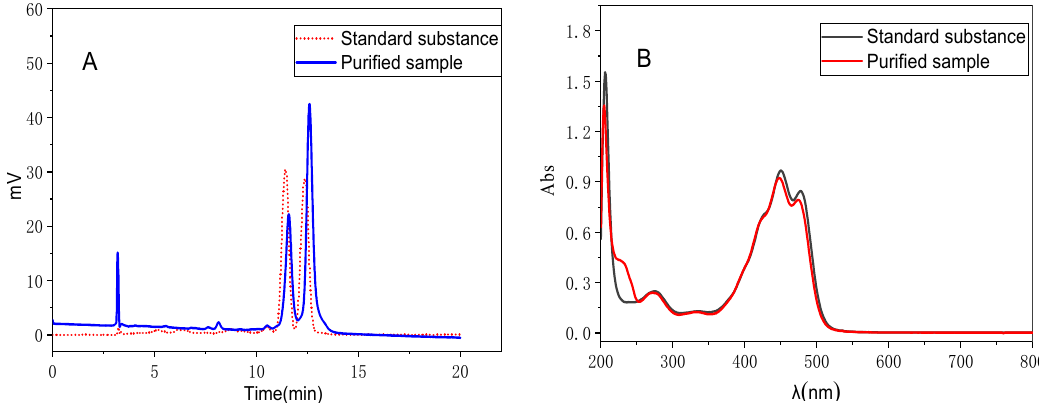
Figure 4. The purity testing of zeaxanthin and lutein: ( A ) HPLC chromatogram and ( B ) ultraviolet visible spectrum.